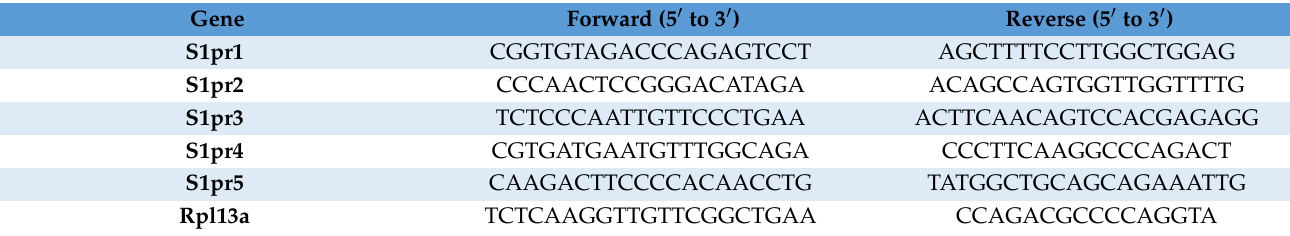
Table 1. List of mouse primers used in qPCR